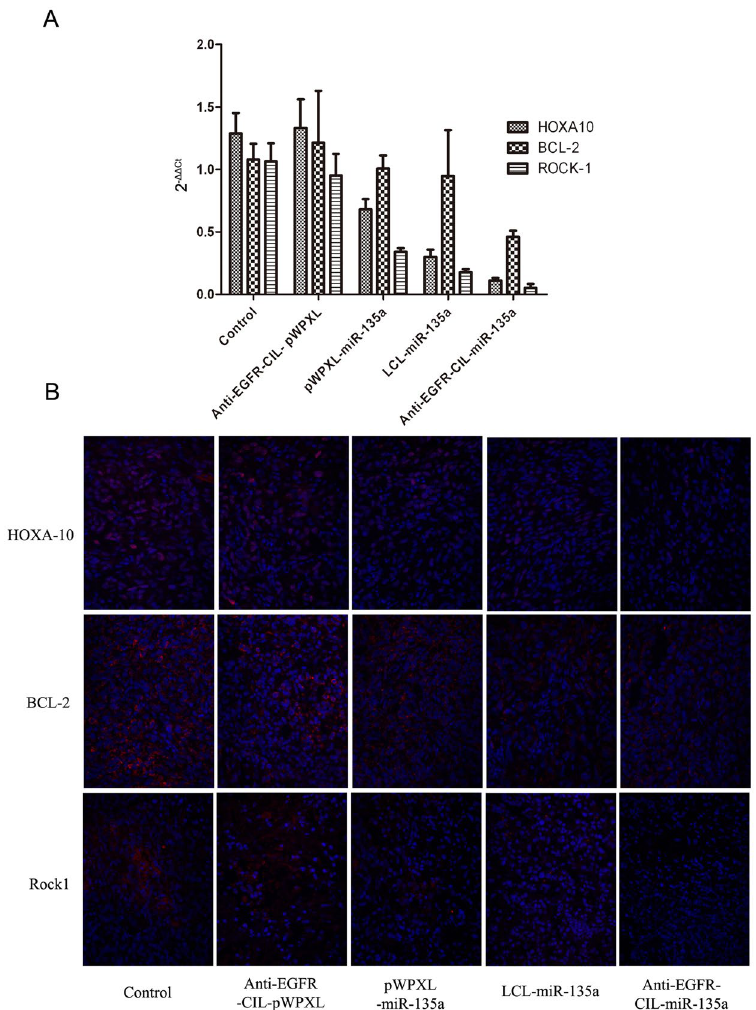
Figure 11. The Anti-EGFR-CIL-miR-135a downregulated the expression of target genes in vivo . ( A ) Down- regulated BCL-2, HOXA10 and Rock1 expression were assessed at the mRNA level by performing qRT-PCR and ( B ) at the protein level by performing an immunofluorescence assay 24 hours after mice were sacrificed and analysed. miR-135a, LCL-miR-135a and Anti-EGFR-CIL-miR-135a at a miR-135a concentration of 1.5 mg/kg ( * p < 0.05 and ** p < 0.01) (n =